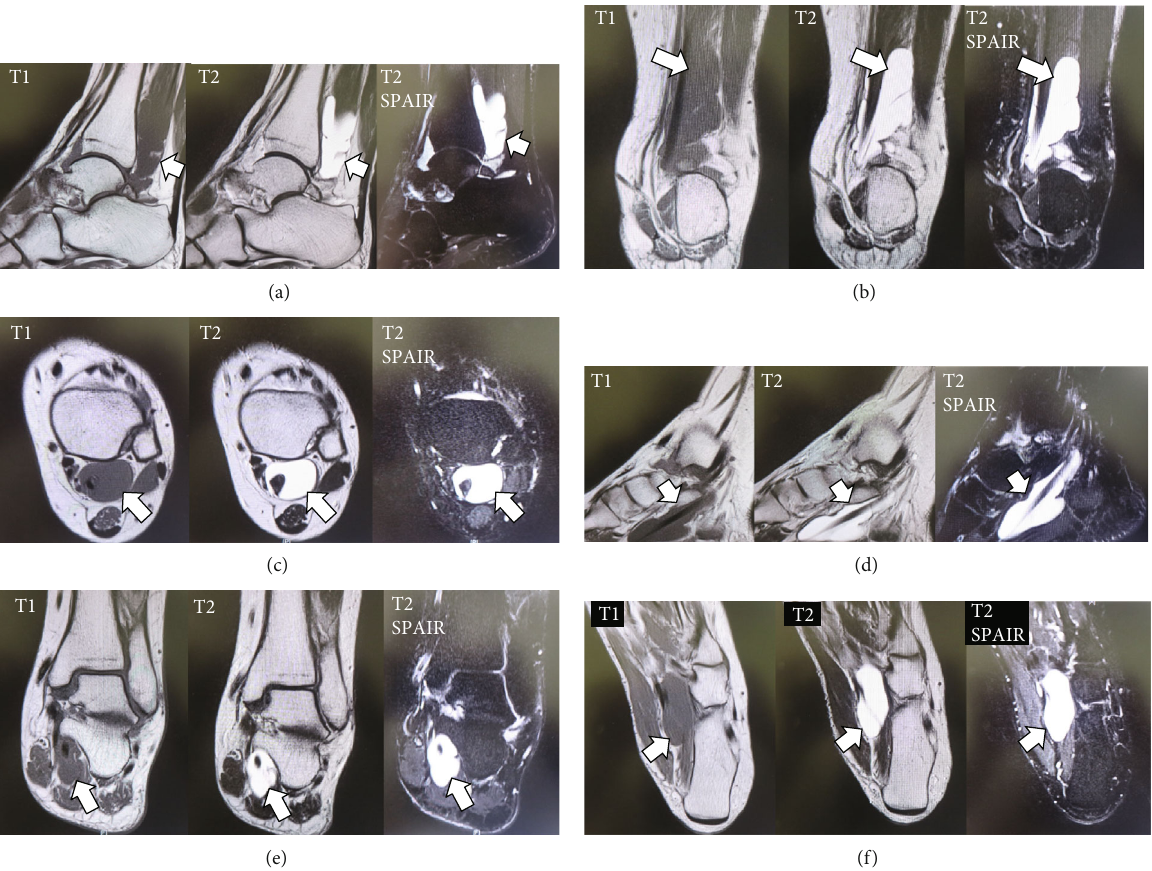
Figure 4: T1-weighted, T2-weighted, and T2-spectral attenuated inversion recovery magnetic resonance images showing a massive e ff usion around the fl exor hallucis longus (arrow) at a level proximal to the ankle joint posteriorly in the (a) sagittal, (b) coronal, and (c) axial planes and between the talar tubercles and the master knot of Henry in the (d) sagittal, (e) coronal, and (f) axial